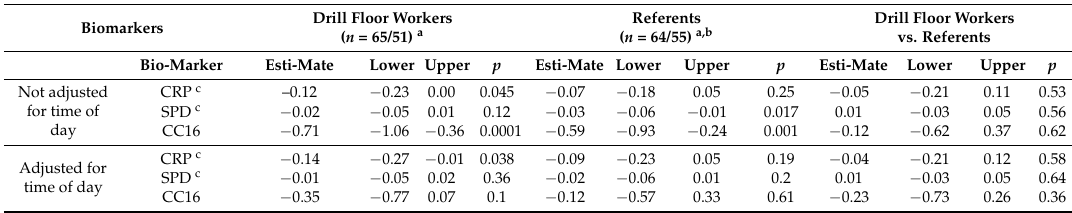
Table 3. Changes in the serum concentrations of C-reactive protein (CRP), surfactant protein D (SP-D) and club cell protein 16 (CC-16) after being adjusted for age, BMI, infection, nicotine and cotinine across a 14-day work period of drill floor workers and referents. Data are also presented for the additional adjustment for time of blood